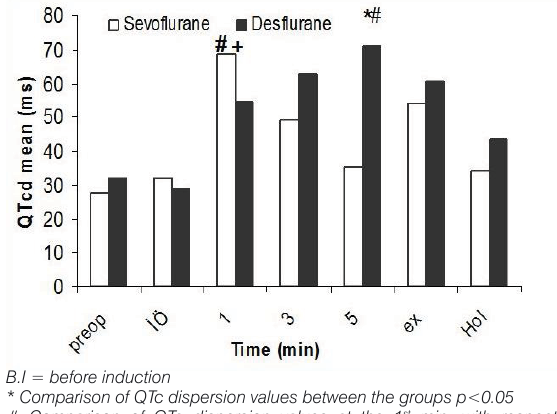
B.I = before induction * Comparison of QTc dispersion values between the groups p<0.05 # Comparison of QTc dispersion values at the 1 st min. with respect to preoperative values intragroup 1 and at the 5 th min. with respect